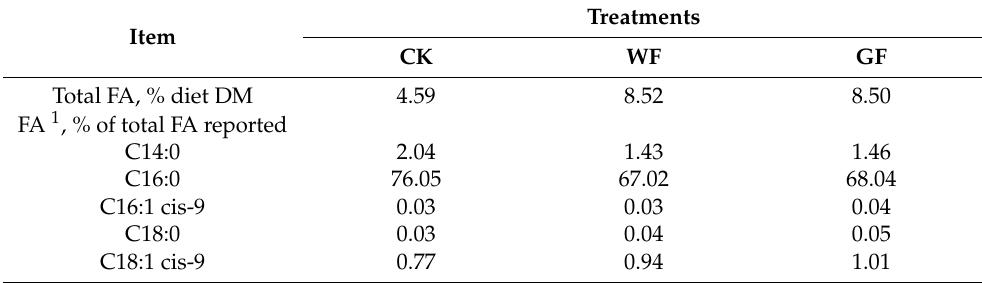
Table 1. Content and composition of fatty acid in experimental diets of different treatment groups.